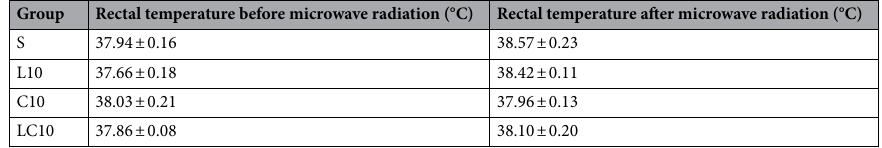
Table 2. Rectal temperatures before and immediately after microwave irradiation (n = 5). Data are shown as the mean ± SE. The data in the table were analyzed by SPSS